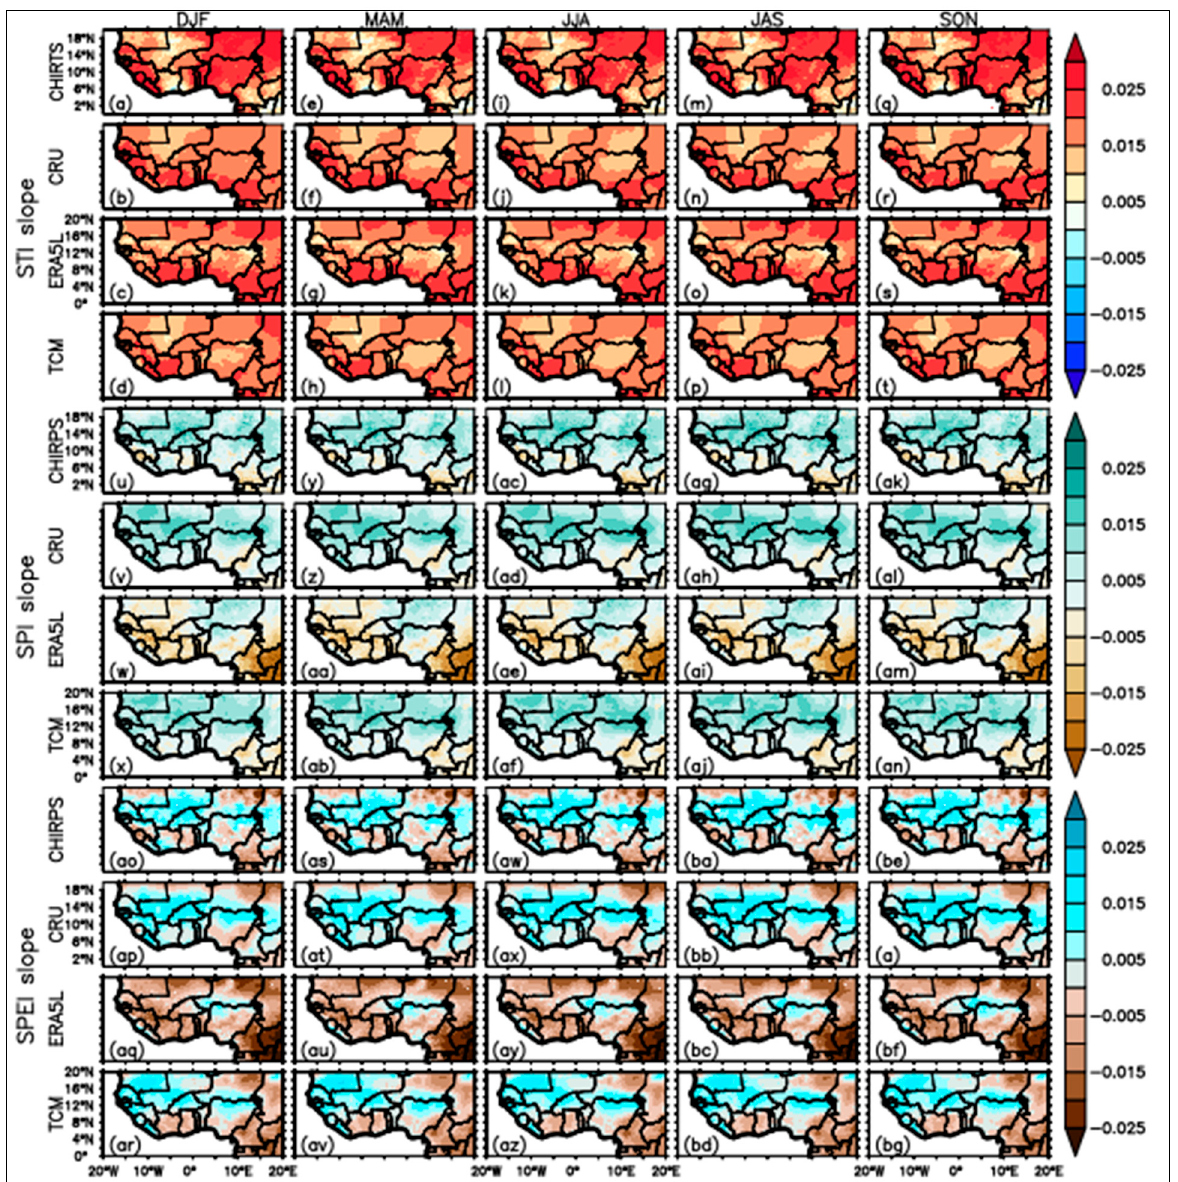
Figure 11. (a – bg) Seasonal rate of average climatic changes over West Africa, based on Sen’s slope estimates